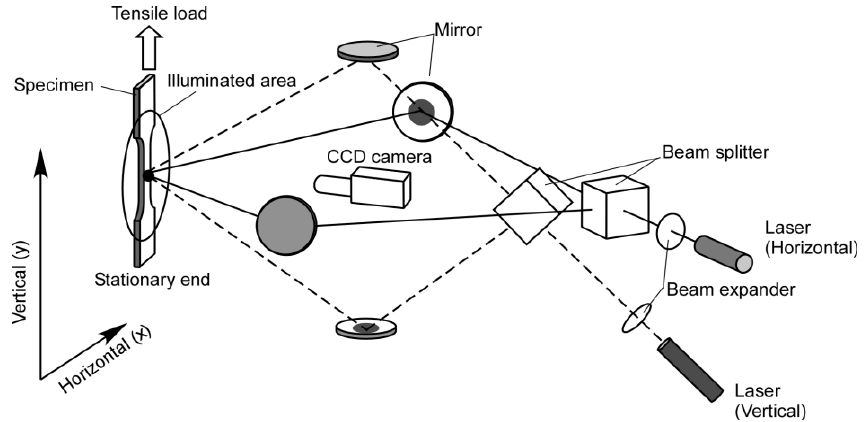
Figure 3. In-plane sensitive Electronic Speckle-Pattern Interferometric